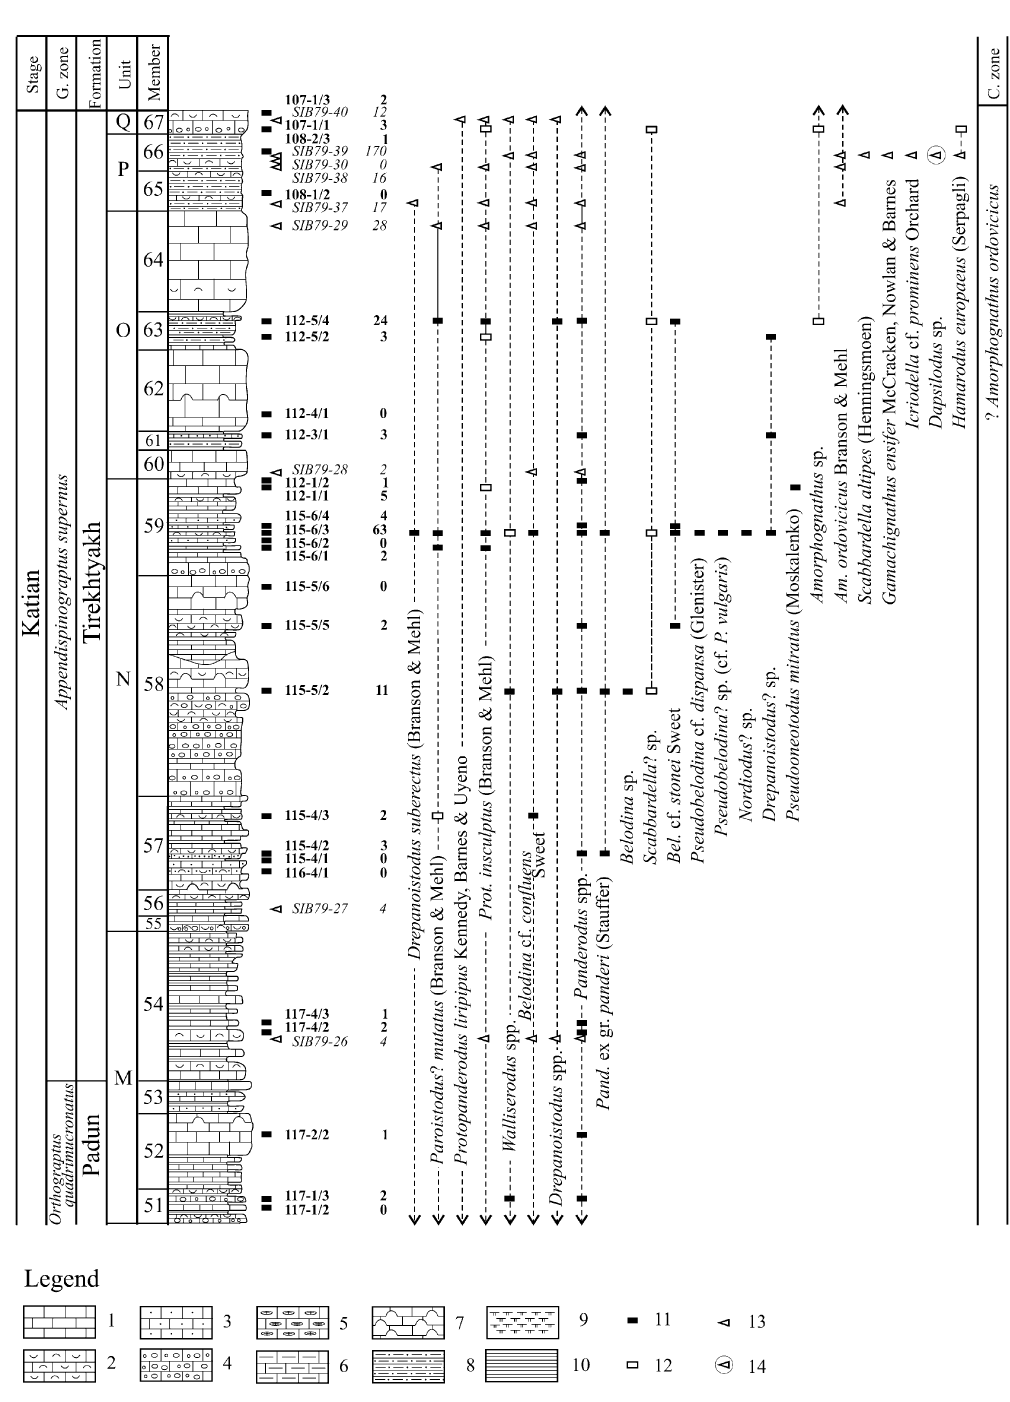
Fig. 4. Distribution of conodonts in the Mirny Creek section, including our data (black rectangles) and those by Zhang & Barnes (2007) (empty triangles). From left to right: global and regional stratigraphy; lithological log (modified from Koren ′ et al. 1983; stage boundaries after Koren ′ & Sobolevskaya 2008); position of samples; sample numbers; number of specimens per sample; distribution of taxa; conodont zonation. Legend: 1, limestone; 2, bioclastic limestone; 3, silty limestone; 4, conglomeratic lime- stone; 5, silicified limestone; 6, argillaceous limestone; 7, bioherms; 8, siltstone; 9, dolomitic marlstone; 10, argillaceous and/or silicified shale; 11, reliable identification of a taxon; 12, problematic identification of a taxon; 13, identification by Zhang & Barnes (2007); 14, revised identification of a taxon illustrated in Zhang & Barnes (2007). Abbreviations: G. zone, Graptolite zone; C. zone, Conodont zone; Prot ., Protopanderodus ; Pand ., Panderodus ; Bel ., Belodina ; Am ., Amorphognathus ; Par ., Paroistodus ; Oul ., Oulodus ; Oz ., Ozarkodina